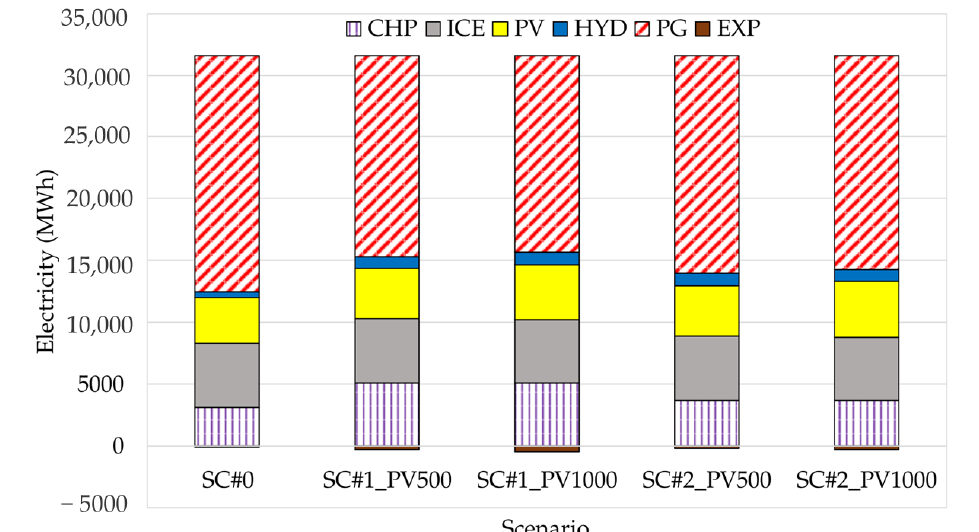
Figure 10. Energy conversion systems used for each scenario to meet the electricity demand of the Tirano community.